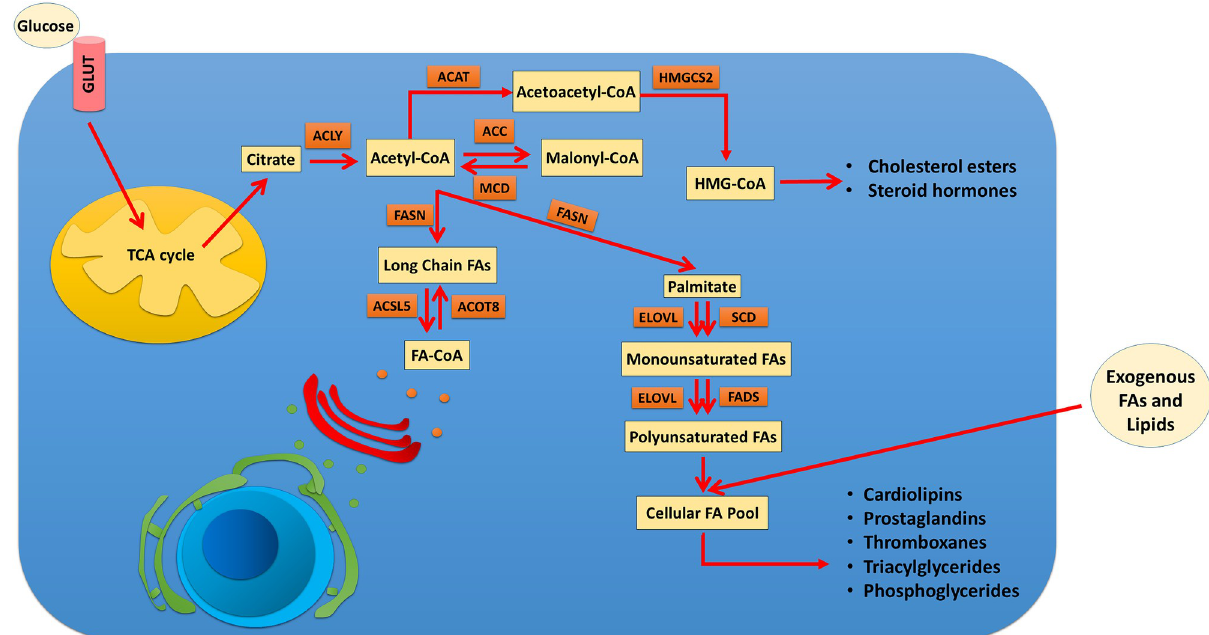
Fig 6. Schematic view of the roles of ACOT8, ACSL5, FASN, HMGBCS2, and SCD1 genes in lipid metabolism.